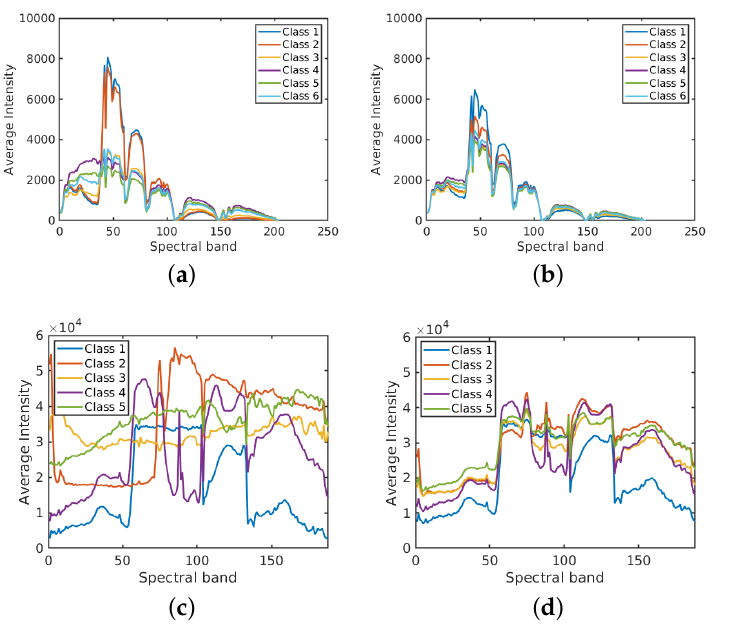
Figure 4. Average spectral signatures for Salinas Scene and HYDICE Urban . ( a ) Salinas Scene with ρ = 0; ( b ) Salinas Scene with ρ = 0.5; ( c ) HYDICE Urban with ρ = 0; ( d ) HYDICE Urban with ρ =